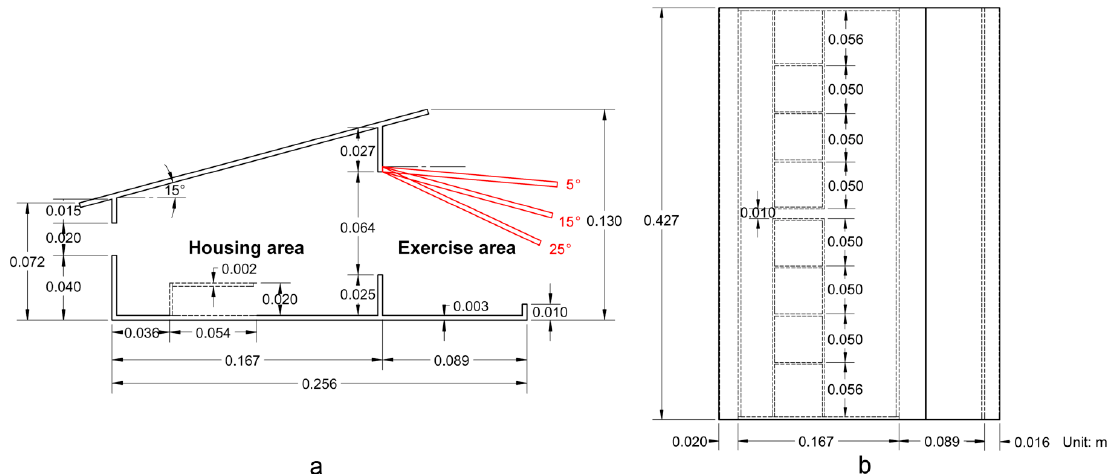
Figure 1. Sketch of the 1:50 scaled pig building model. ( a ) Front view with different slopes of the roof above the exercise yard; ( b ) top view of the scaled model with 15° roof slope.